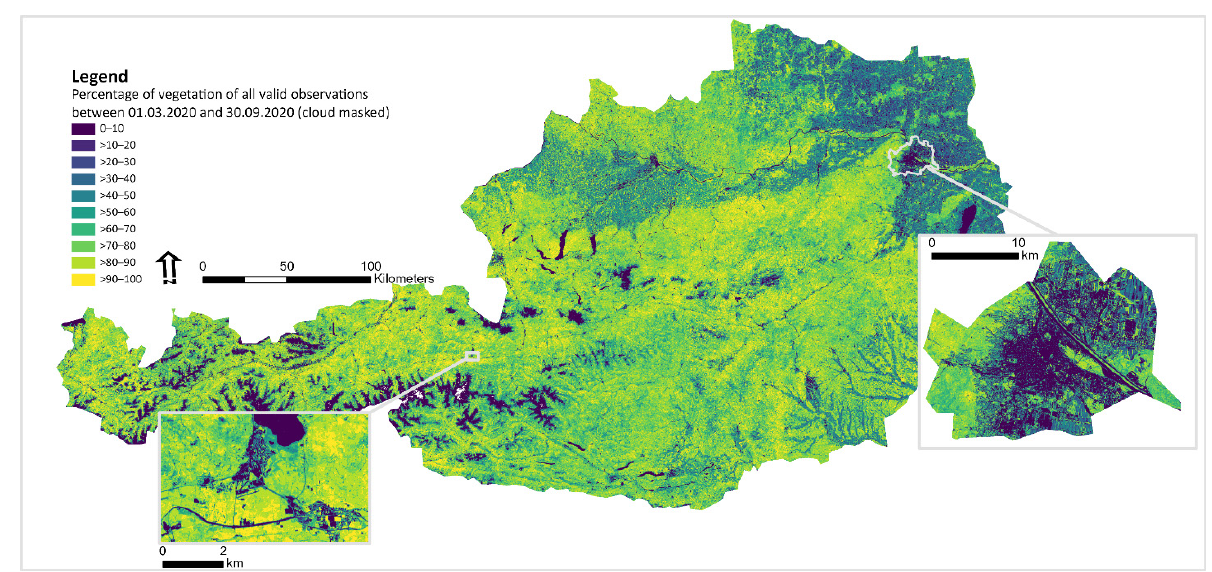
Figure 5. A vegetation percentage over time within the vegetation season (1. March 2020–30 September 2020) based on semantic concepts and with excluded clouds on 10 m ground resolution. Users can define their vegetation concept graphically and semantically, i.e., based on the meaning of the spectral categories and without arbitrary thresholds of vegetation indices as it is required in other non-semantic approaches. It is possible to mask out clouds easily and without relying on per-image statistics or on algorithms with known problems [60]. From the user perspective, this analysis was generated in a web-browser without other hardware than a standard office computer and without programming and can be repeated for other time steps and/or areas by re-using the created model. Inset on the right shows Vienna, inset on the left the southern part of the city Zell am See.